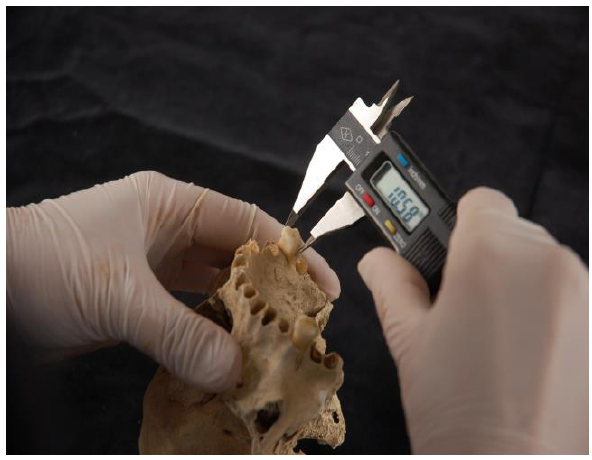
Figure 7. Manual odontometry